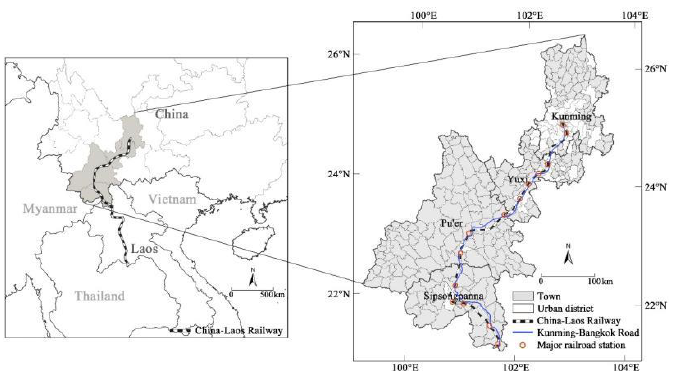
Figure 1. Location and distribution of small towns in the Yunnan section of the China – Laos Economic Corridor.